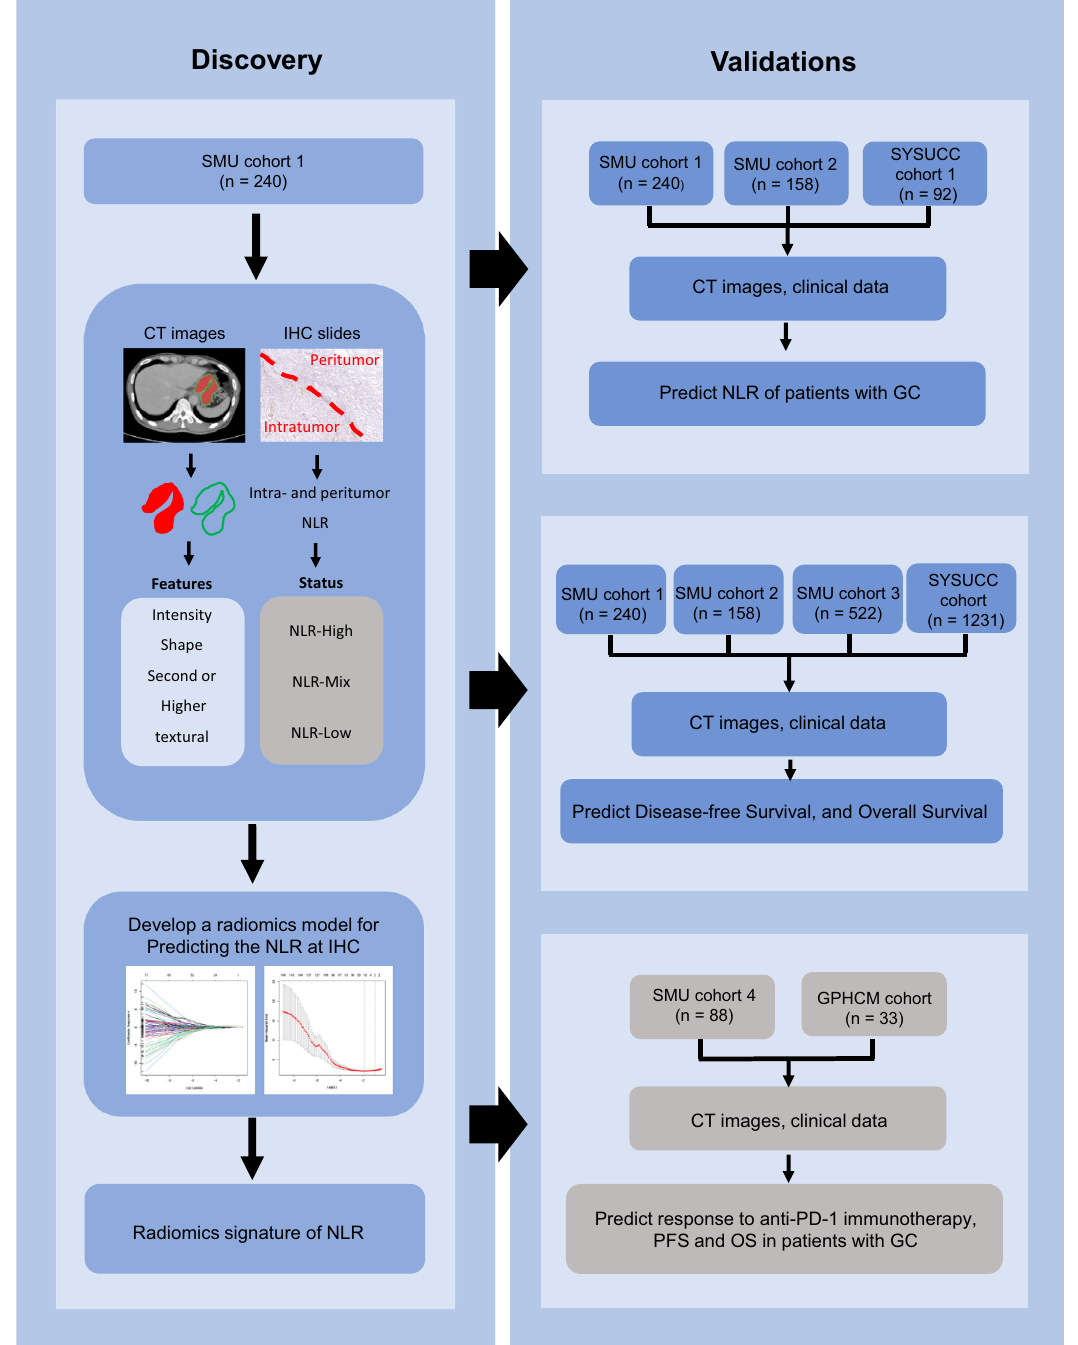
Fig. 1 | Study design for the discovery and validation of the radiomics imaging biomarker of NLR in gastric cancer. SMU cohort 1 was the training cohort for developing the radiomics imaging biomarker. SMU cohort 2 and SMU cohort 3 were the internal validation cohorts. SYSUCC cohort 1 and SYSUCC cohort were